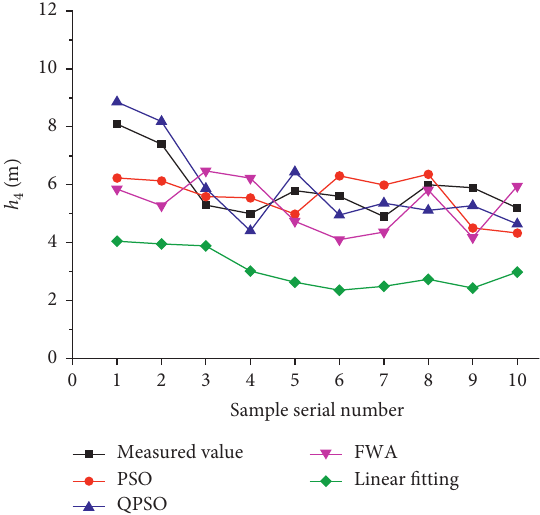
4 when the number of BP Figure 13: The prediction curve of h